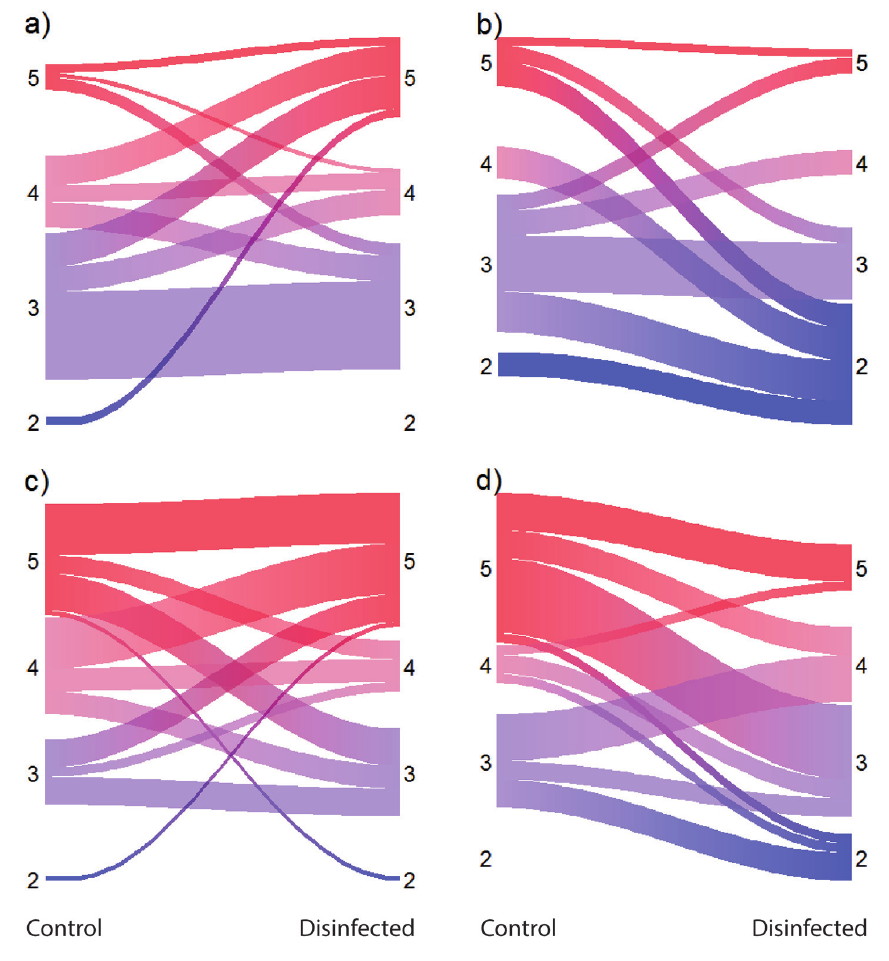
Figure 3. Flow diagram visualising the efficacy of footwear disinfection measures aboard a cruise ship on Svalbard. Numbers on the y-axes and colours represent growth scores (see Table 1), lines connect paired control and disinfected samples and the width of lines is proportional to the number of samples in each category. a) step-through disinfection after 24 hours b) step-through disinfection combined with a pro- longed drying period after 24 hours c) step-through disinfection after 48 hours d) step-through disinfec- tion combined with a prolonged drying period after 48